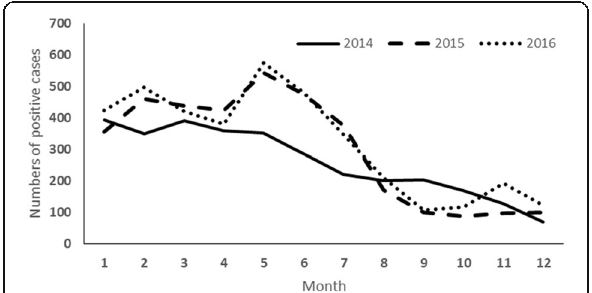
Fig. 2 Monthly dengue cases were reported from the local hospital in Bandung from 2014 to 2016